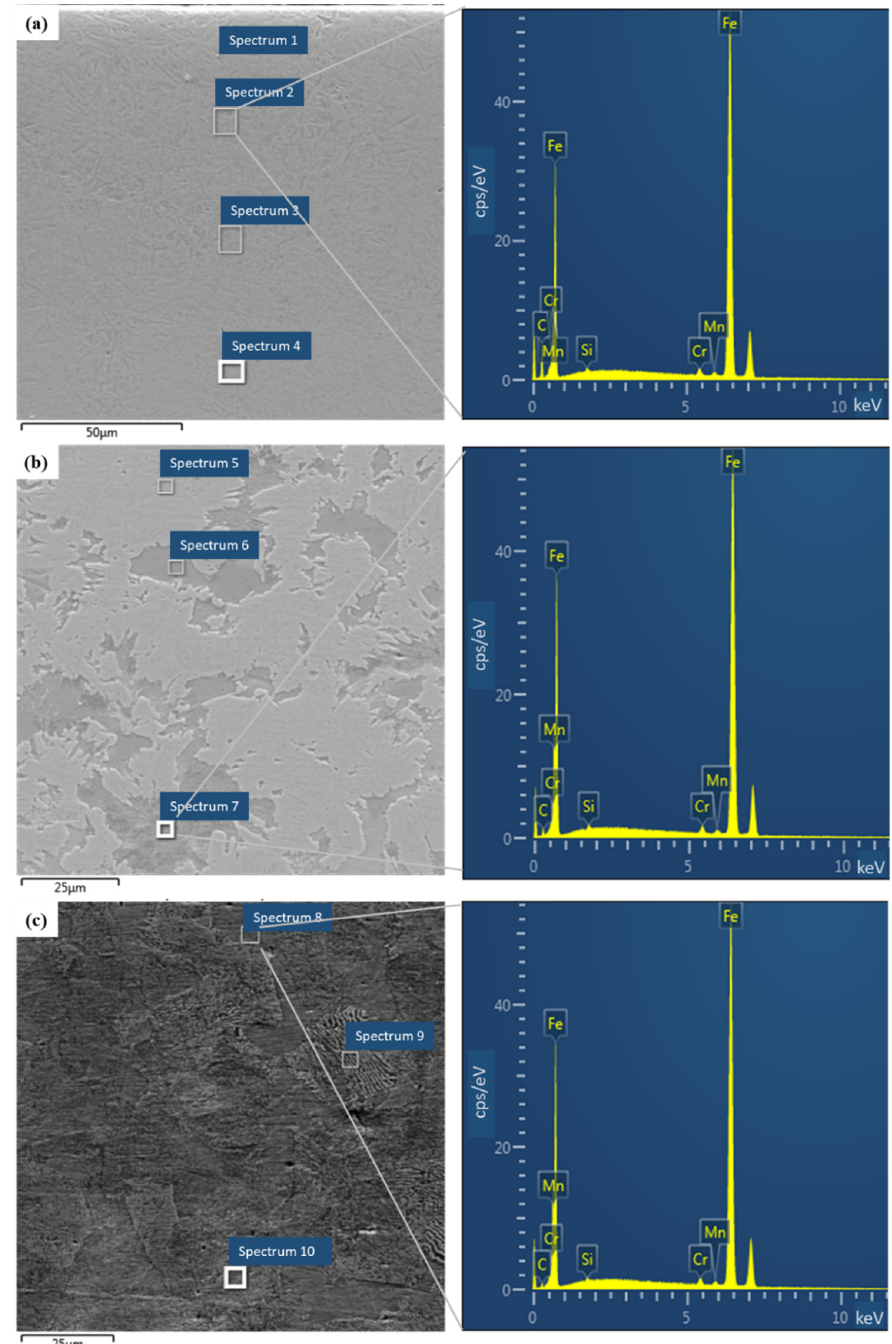
Figure 8. Schematic graph of EDS testing zones: ( a ) hardened layer, ( b ) heat affected zone and ( c ) unaffected material.